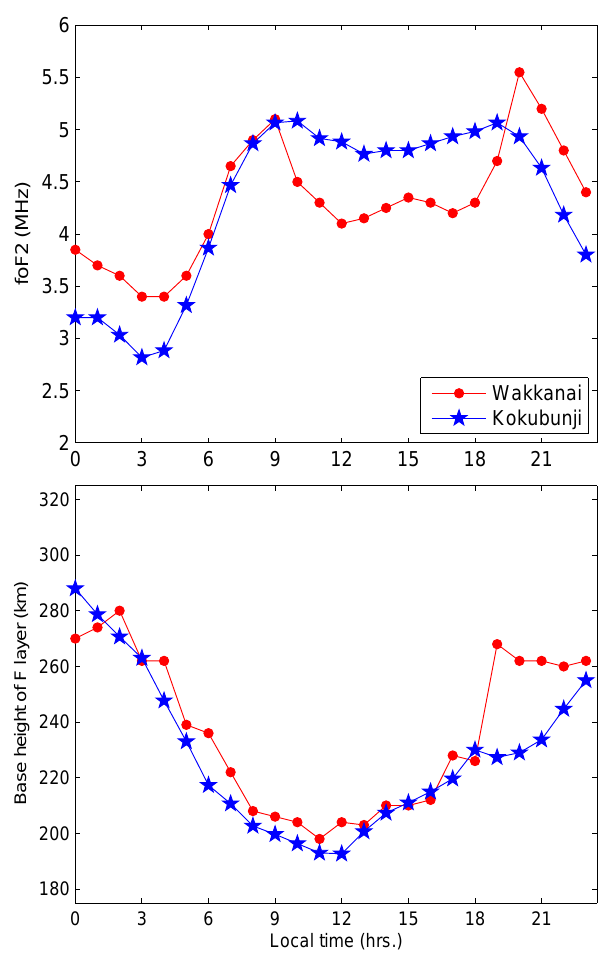
Fig. 5. Temporal variation of monthly mean fo F2 (top) and h 0 F (bottom) from Wakkanai and Kokubunji during July